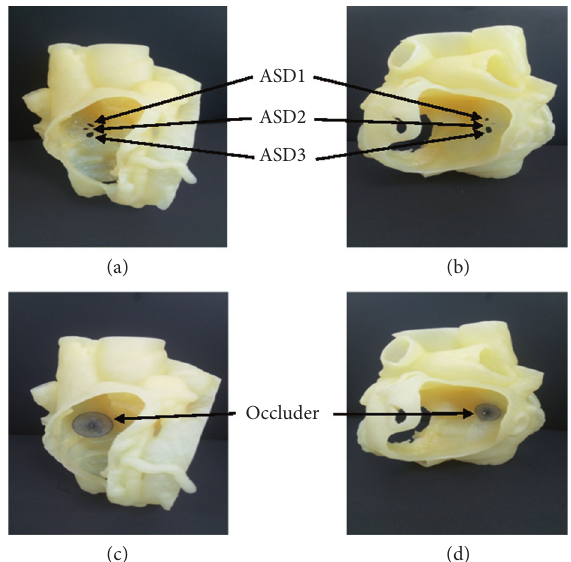
Figure 2: 3D printed model of a patient with multiple ASDs. (a) and (b) show the model viewed from left and right atrial sides, respectively. The arrows depict the position of the multiple ASDs. (c) and (d) illustrate the status after occluder deployment in the 3D printing model.